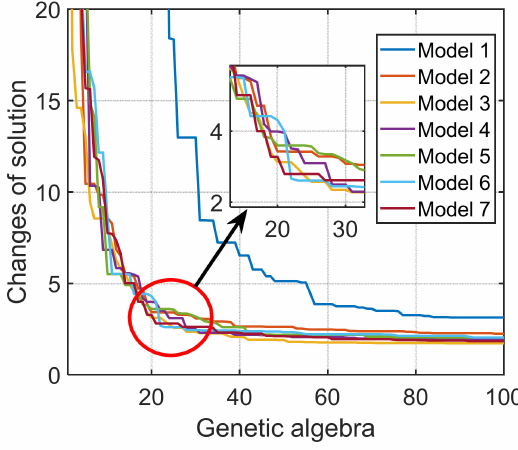
Figure 10. Iterative evolution curve of I-GA (seven